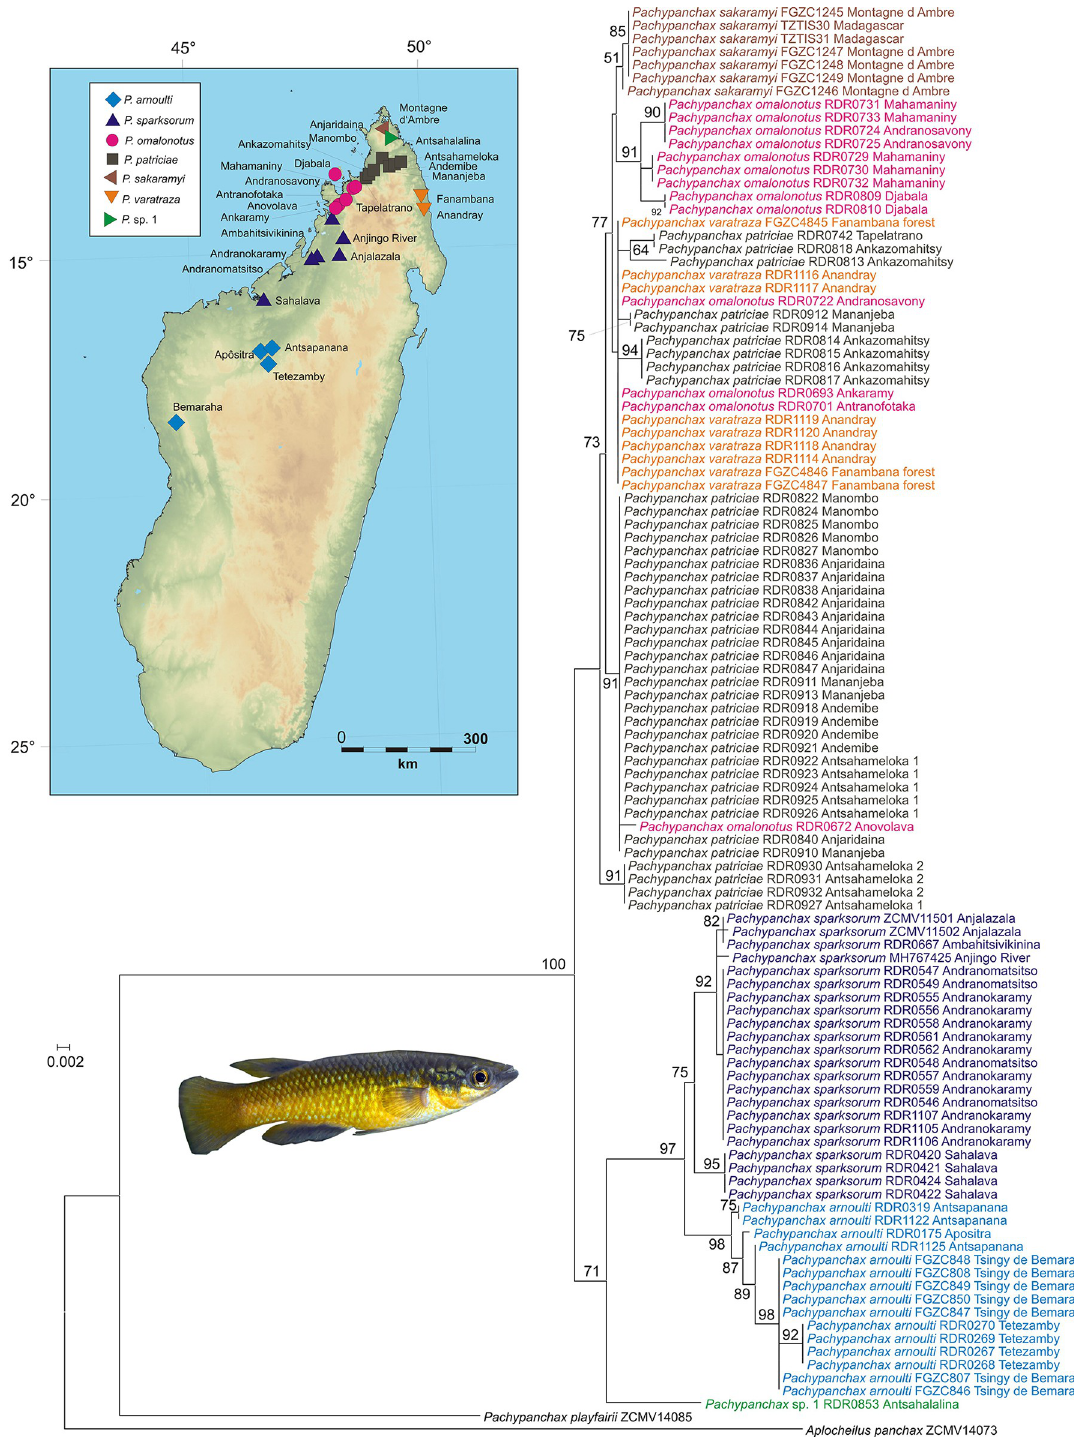
Fig 2. Geographic distribution of sample sites of Malagasy species of Pachypanchax (Aplocheilidae) from which sequences were available for this study, and mitochondrial Approximate Maximum Likelihood tree of combined COI and 16S gene fragments (total alignment length 1199 nucleotides), calculated with FastTree. Numbers at nodes are SH-like local support values in percent (shown only if > 50%). The inset shows a photo of P . sakaramyi . Map colors represent elevations; drawn with the open-source Python library matplotlib/basemap (https://github.com/matplotlib/basemap).